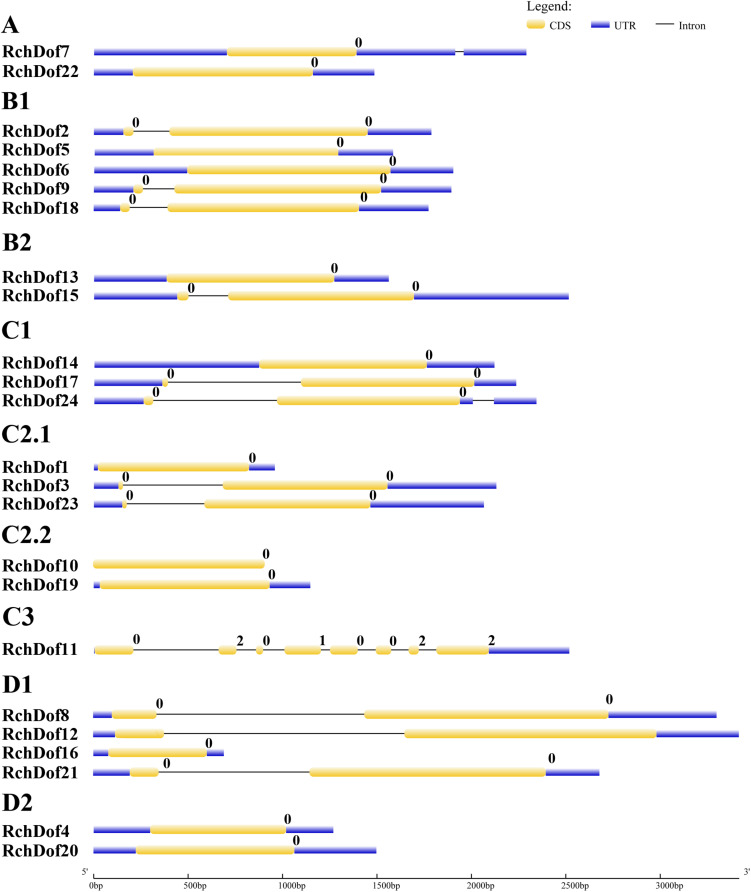
Exon–intron structures of RchDof genes. The exons and introns are indicated by yellow rectangles and black lines, respectively. The length of RchDof proteins can be estimated using the scale at the bottom. The intron phases are indicated as numbers 0, 1, and 2.